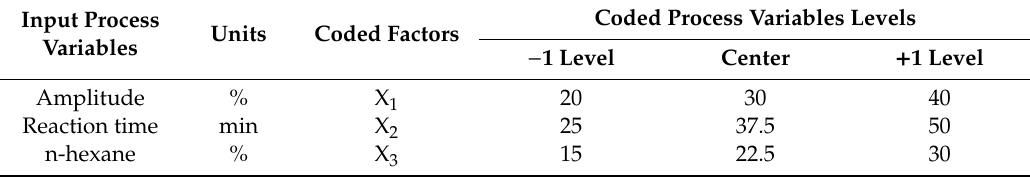
Table 2. Independent input process variables used for the optimisation of biodiesel yield.